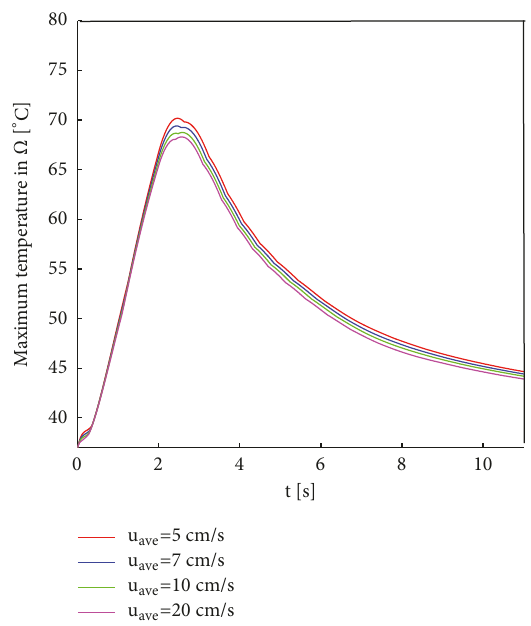
Figure 10: Maximum temperature in space 𝑟, 𝑧 ∈ Ω versus time with different average velocity of blood flow for 𝑝 0 = 2 × 10 5 𝑝𝑎 , 𝑟 = 0.5 𝑚𝑚 , 𝑑 = 0𝑚𝑚 , 𝜏 = 1.756 𝑠 , 𝑓 0